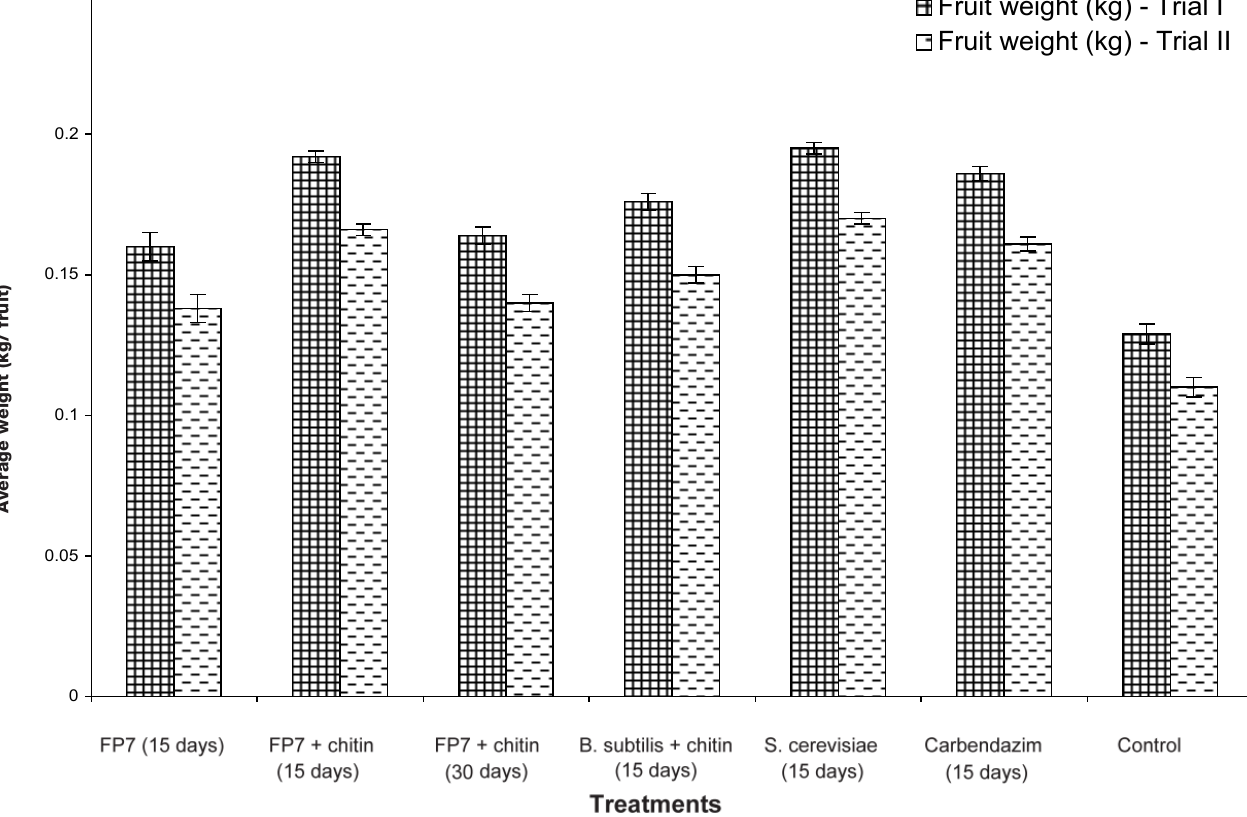
Fig. 4. Effect of pre-harvest application of biocontrol formulations on fruit weight in